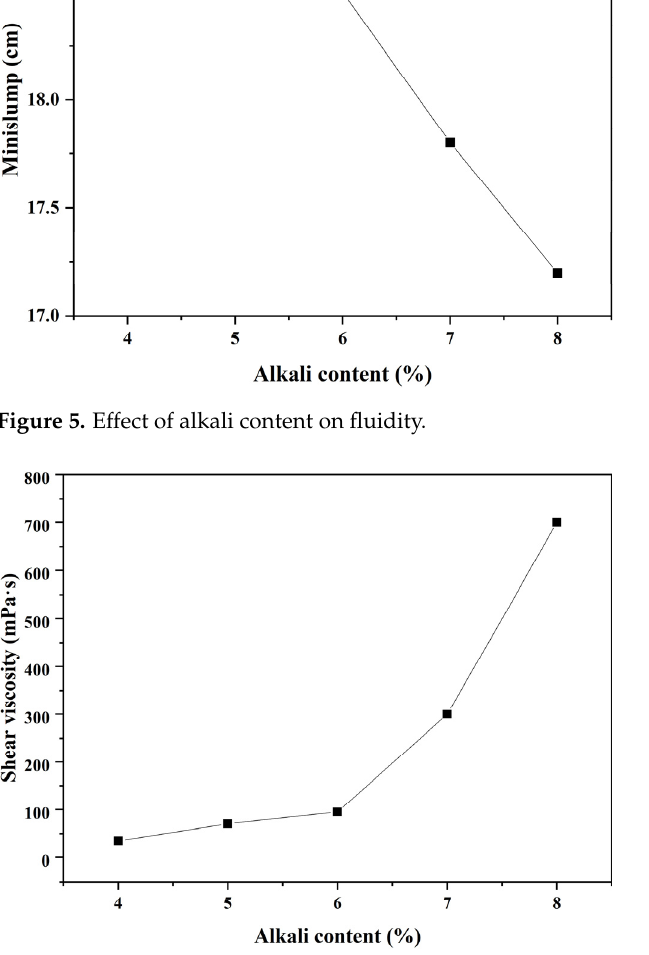
Figure 6. Effect of alkali content on shear viscosity.